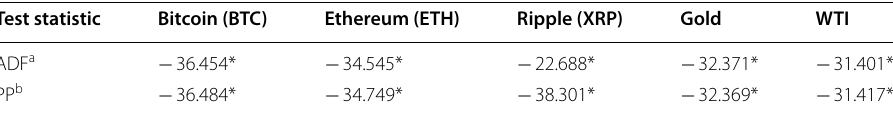
Table 2 Results of unit root tests for return